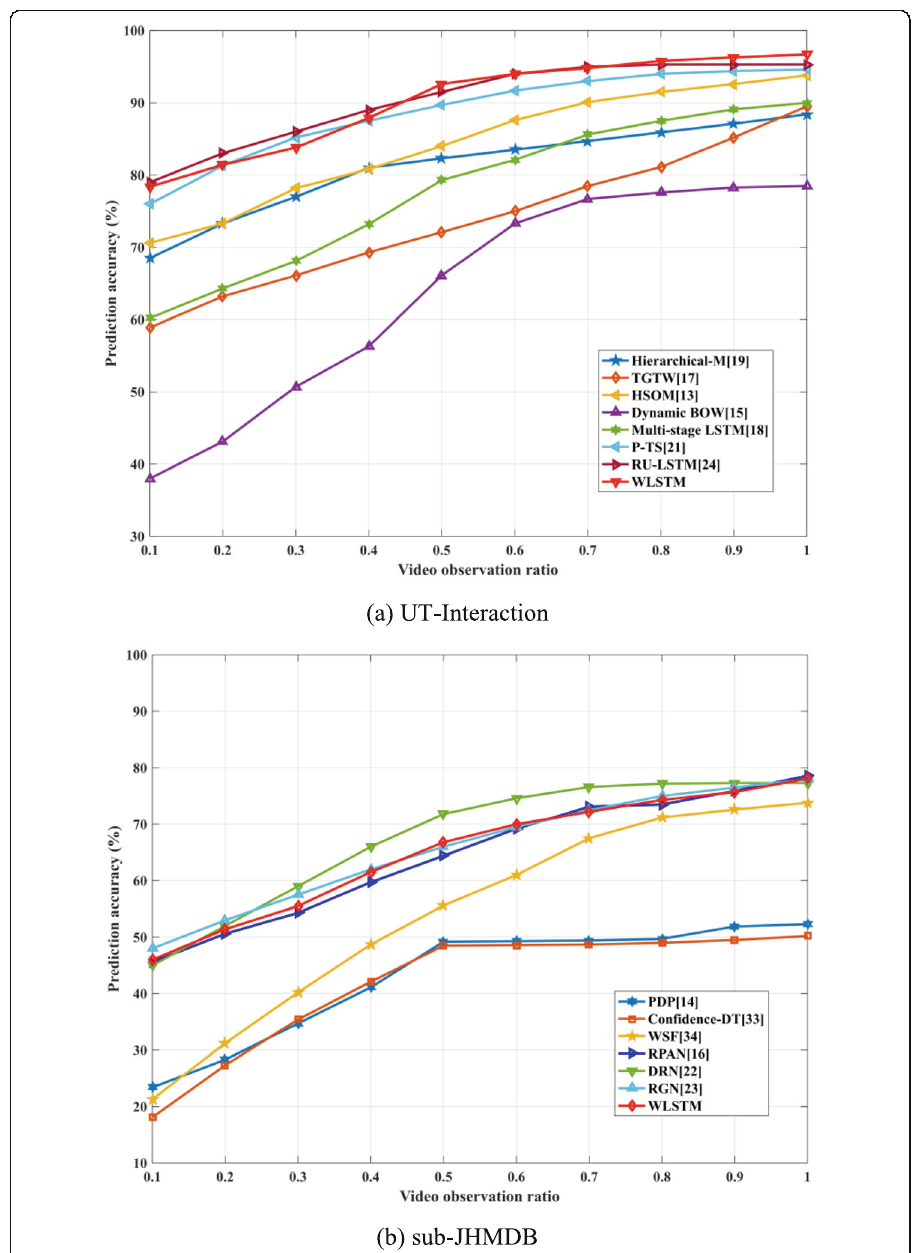
Fig. 10 Prediction accuracy comparison under different video observation ratio. a UT-Interaction. b